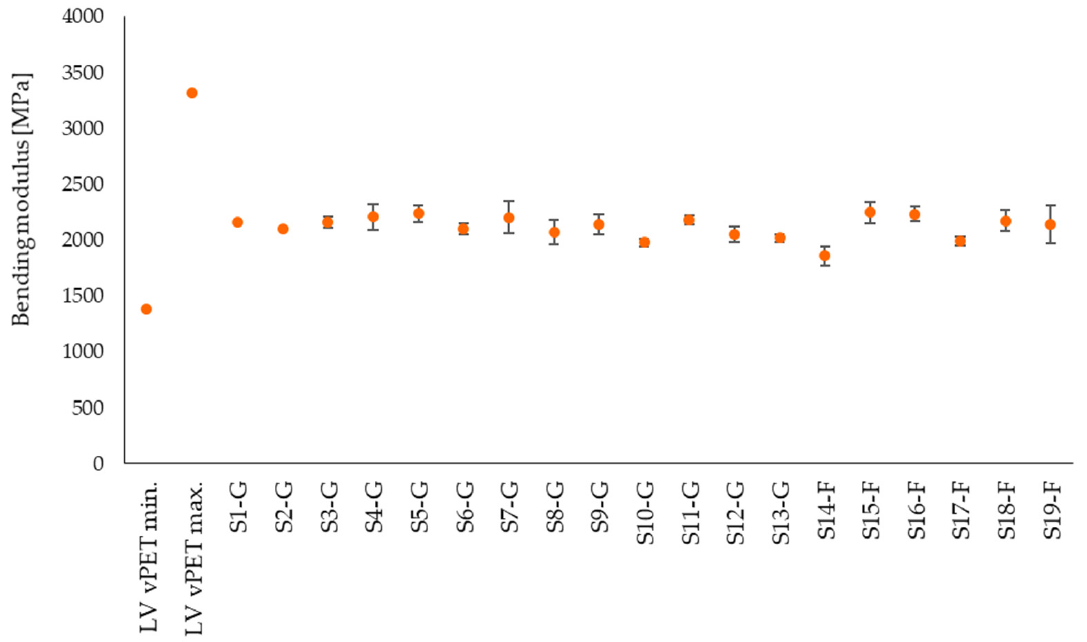
Figure 8. Experimentally determined bending modulus of rPET samples in comparison with literature values for vPET.